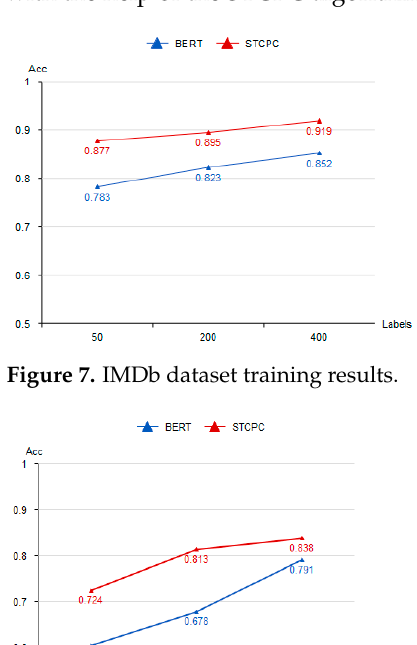
Figure 9. Sogou News dataset training results.